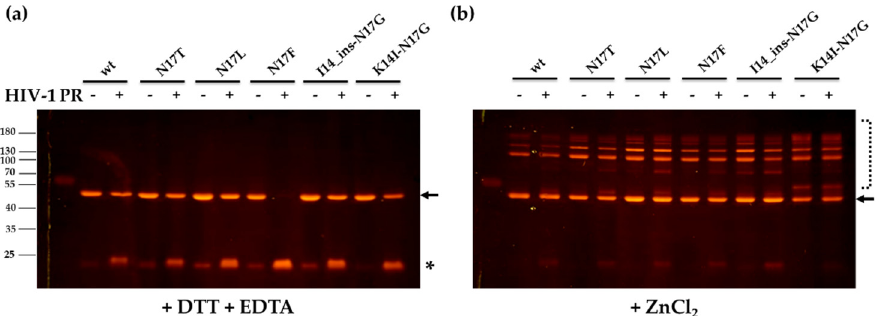
Figure 5. The cleavage of recombinant protein substrates with HIV-1 PR. Cleavage reactions were performed with HIV-1 PR, using buffers supplemented either with DTT and EDTA ( a ) or ZnCl 2 ( b ). After the cleavage of recombinant substrates, the separation of substrates and cleavage products with PAGE was performed using non-denaturing conditions. The proteins were detected in the gel using blue-light transillumination. Arrows indicate bands of the uncleaved substrates, while asterisk indicates bands of the cleavage products containing the C-terminal mApple fluorescent protein. The dashed line ( b ) indicates putative oligomers.